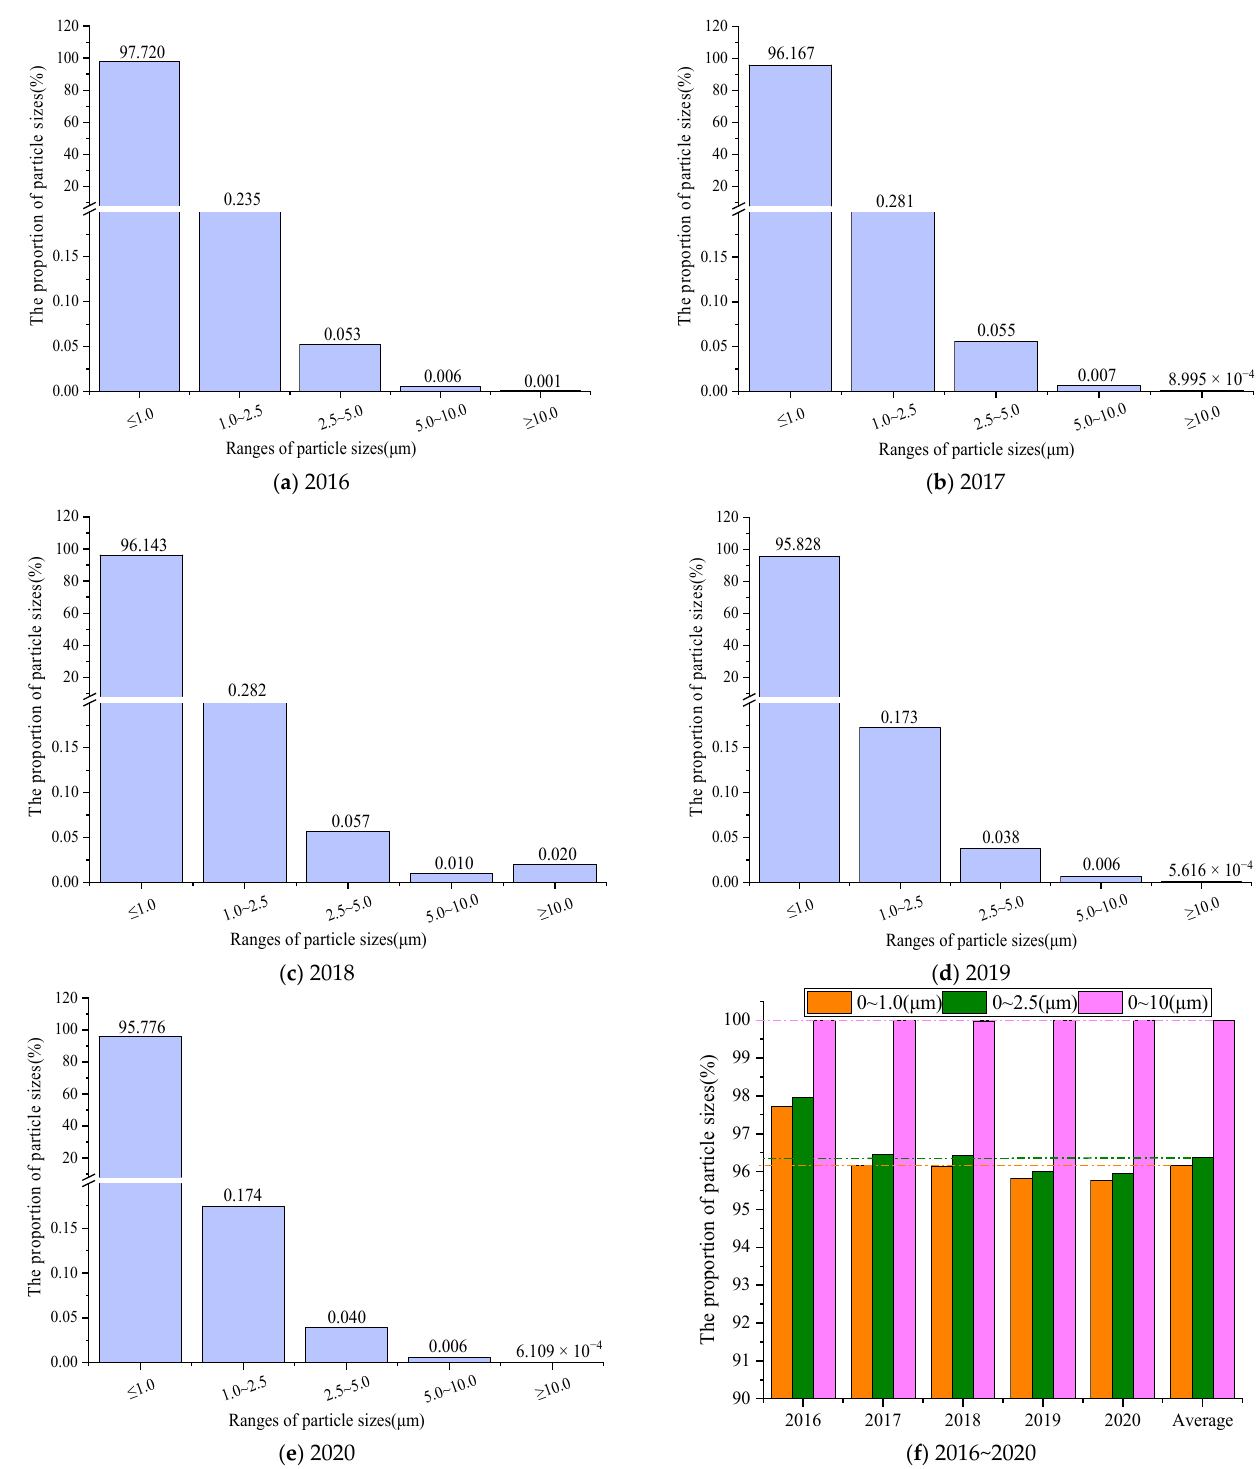
Figure 5. Distributions of outdoor atmospheric particle sizes (average temperature of 19.9 °C~25.5 °C; average humidity of 38.9~50.9%).